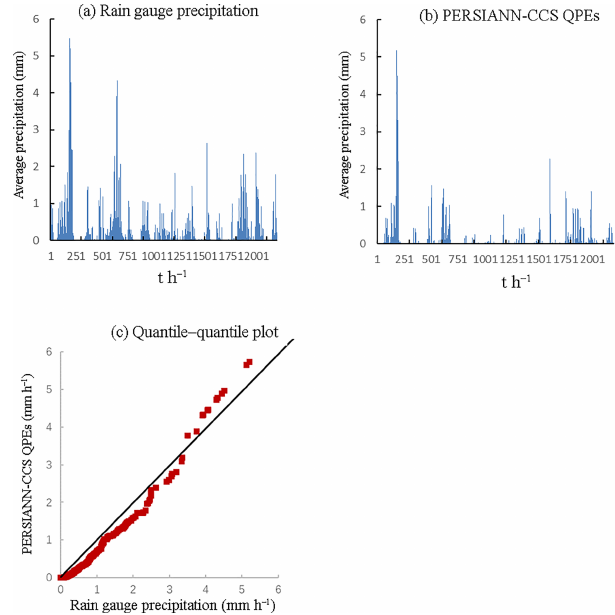
Figure 8. Precipitation pattern comparison of two precipitation products (2013): (a) is the average precipitation of rain gauges, (b) is the average precipitation of PERSIANN-CCS QPEs, and (c) is the quantile–quantile plot, in which the 45 ◦ line is used to compare the two precipitation products.